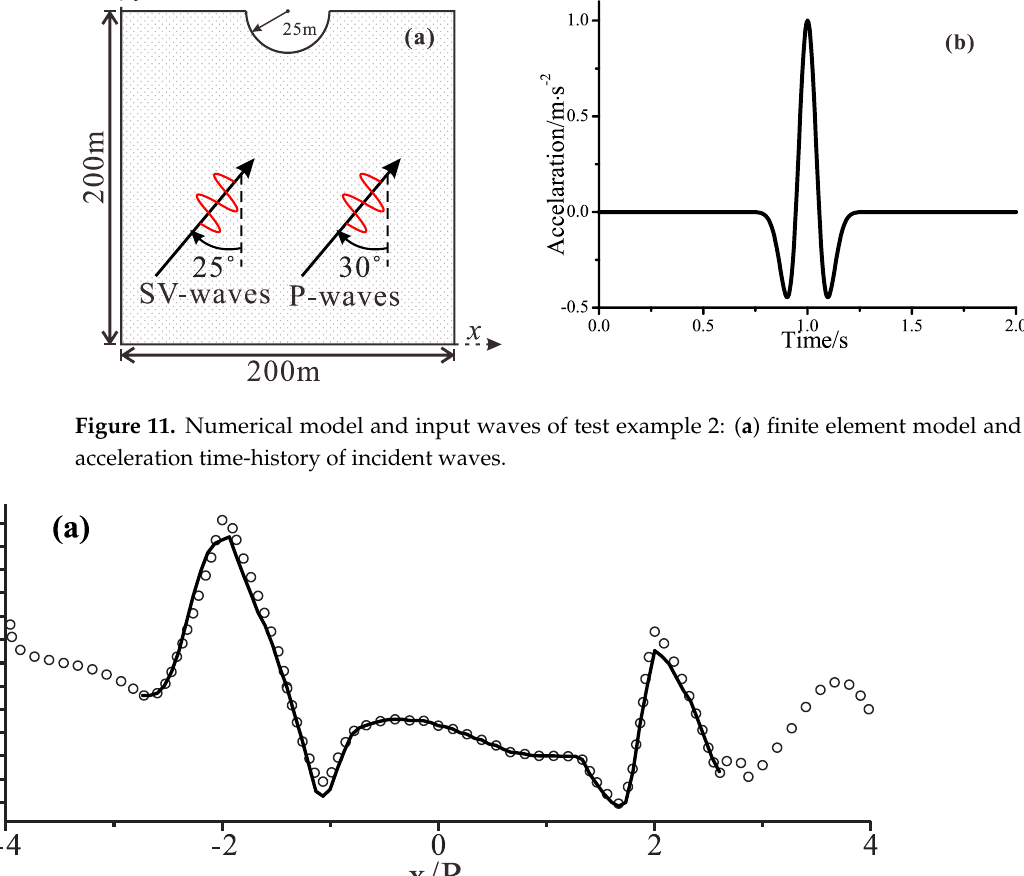
Figure 11. Numerical model and input waves of test example 2: ( a ) finite element model and ( b ) acceleration time-history of incident